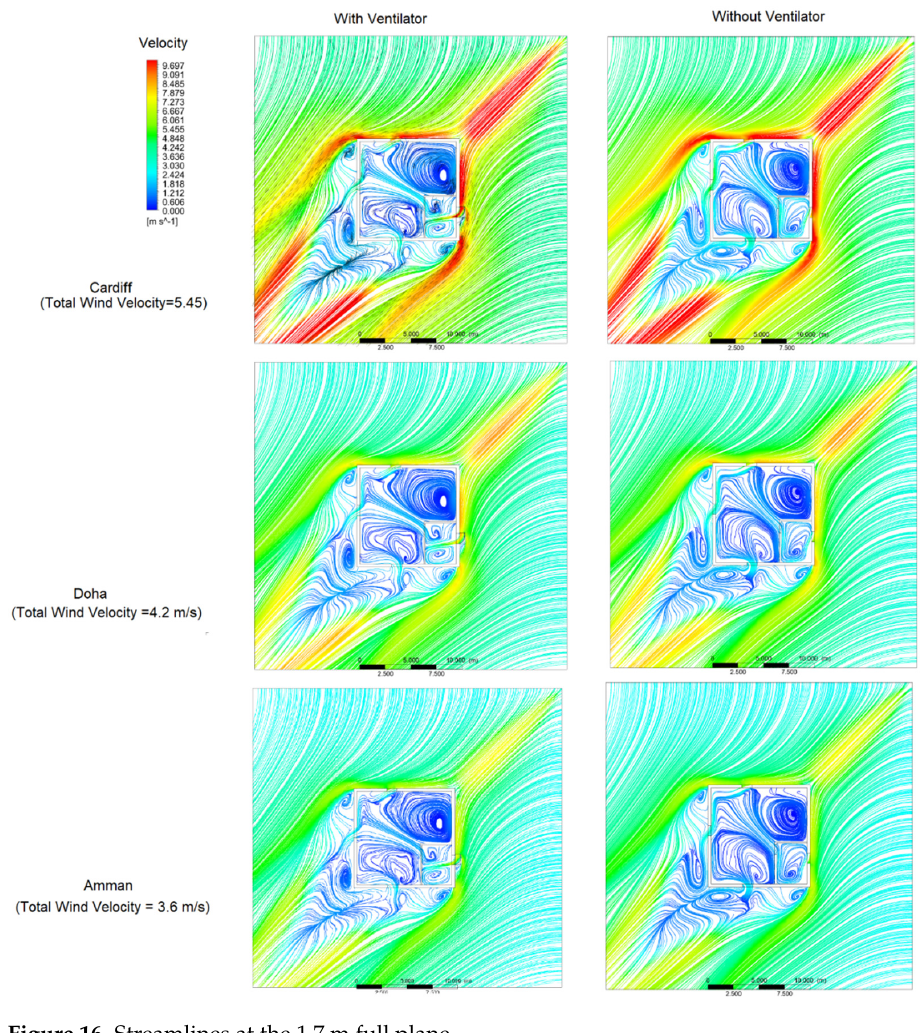
Figure 16. Streamlines at the 1.7 m full plane.